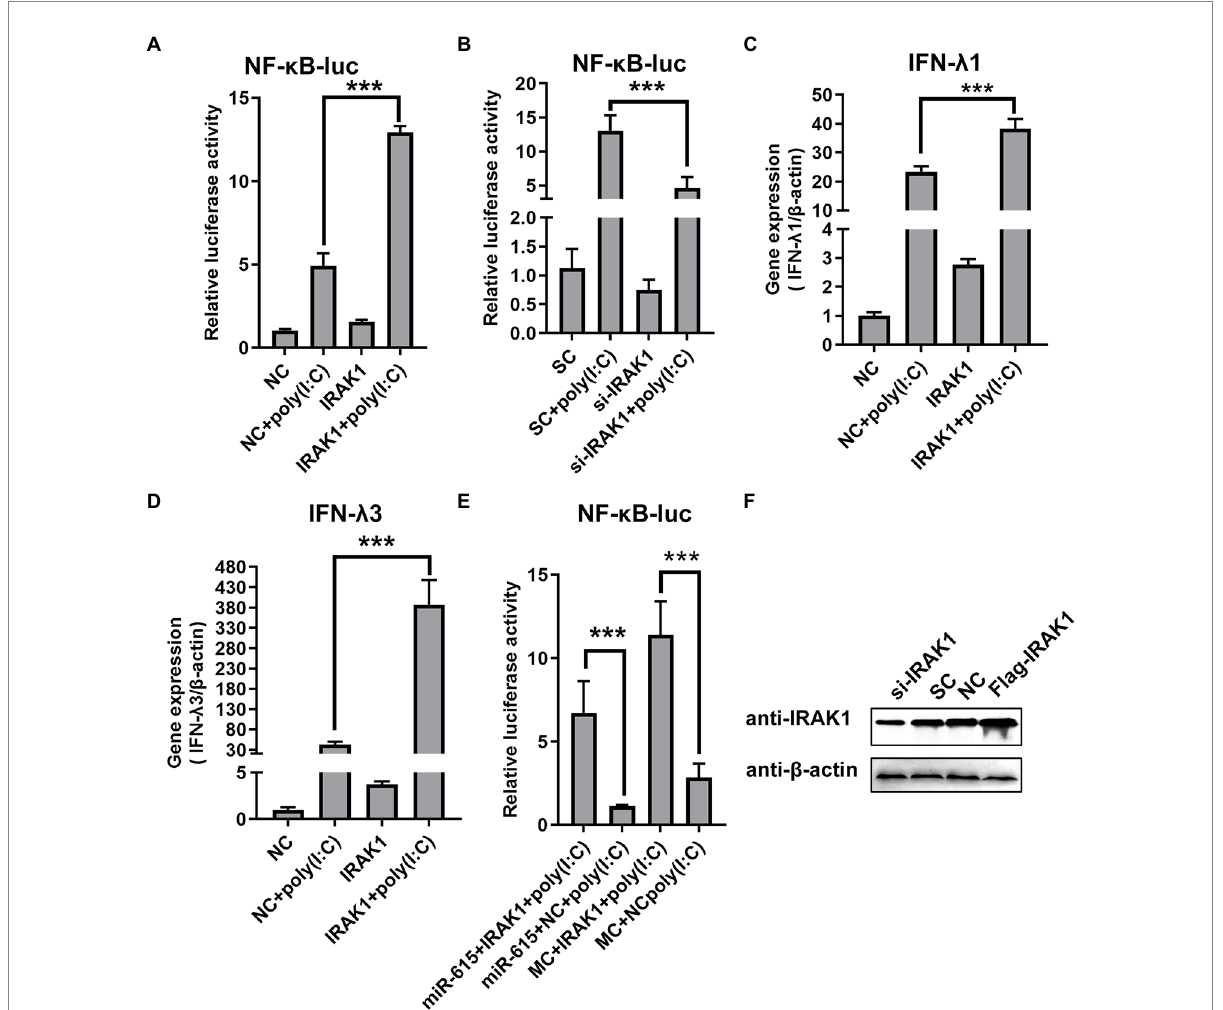
FIGURE 7 miR-615 inhibits NF- κ B pathway activation by regulating IRAK1 . (A) IRAK1-flag or negative control (NC) and (B) si- IRAK1 or siRNA control (SC) were co-transfected with pNiFty-luc and pRL-TK into IECs. Cells were then stimulated with poly (I:C) and infected with PEDV (MOI = 1) at 24 h post- infection (hpi) or left untreated (unstimulated). Cells were then collected for the dual-luciferase reporter assay. (C,D) IECs were transfected with IRAK1 -flag (or NC) or si-IRAK1 (or SC) for 24 h. Poly (I:C) stimulation and viral infection were then induced. After 24 h, IECs were collected for RT- qPCR to determine (C) IFN- λ 1 and (D) IFN- λ 3 expression. (E) Rescue experiment. Luciferase activity was rescued by IRAK1 overexpression. IECs were co-transfected with miR-615 (or MC) and IRAK1 -flag (or NC). At 24 hpi, poly (I:C) stimulation and viral infection were induced. After 24 h of stimulation, cells were collected and the luminescence activity was determined. (F) IRAK1 knockdown and overexpression were confirmed using western blotting. The data are representative of three independent experiments (mean ± SD). *** p <